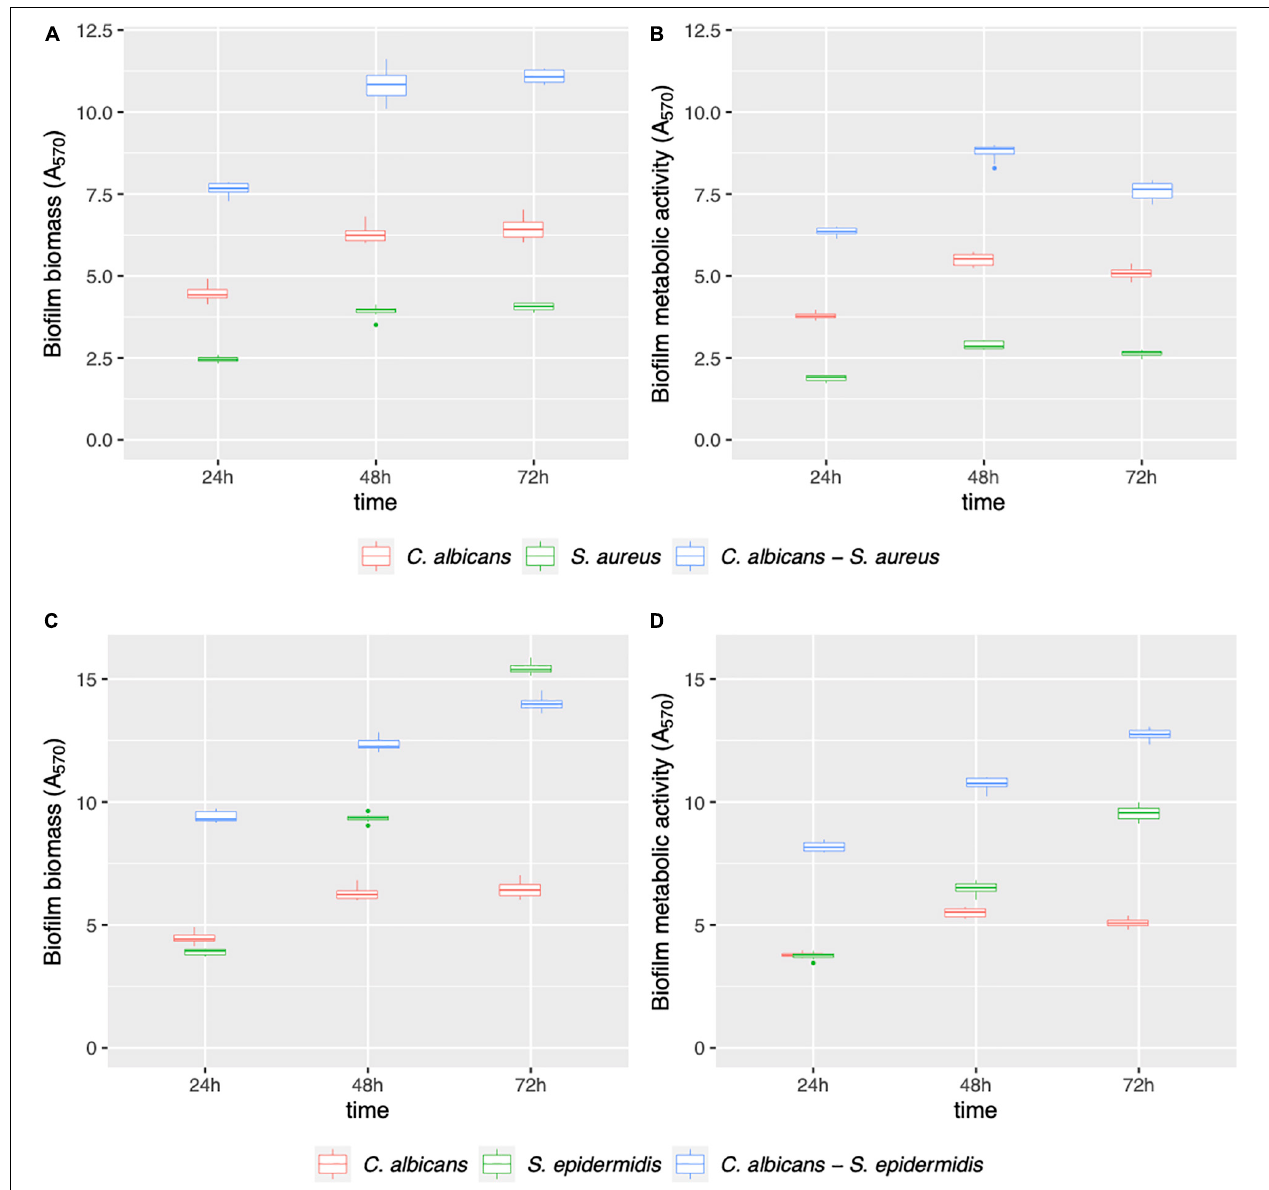
FIGURE 1 | Mono- and dual-species C. albicans – Staphylococcus spp. biofilm formation on polystyrene. The ability of microbial strains to form biofilms was evaluated at 24, 48, and 72 h by biofilm biomass (A,C) and biofilm metabolic activity (B,D)